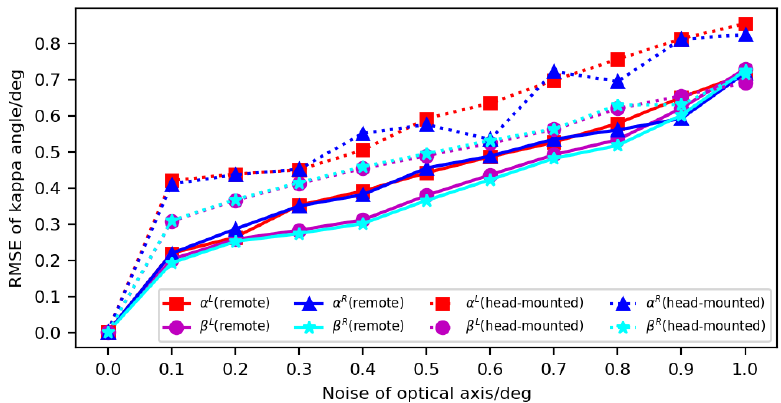
Figure 8. Influence of OA error on kappa-angle